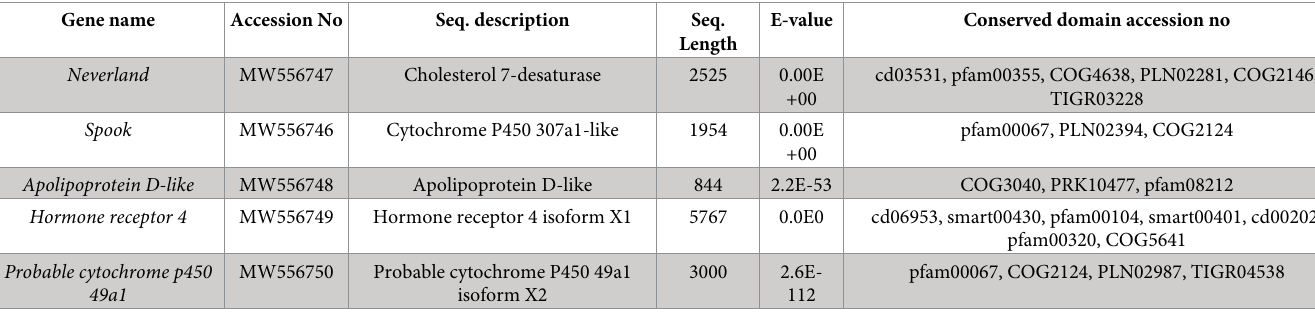
Table 5. List of the candidate genes and their associated conserved